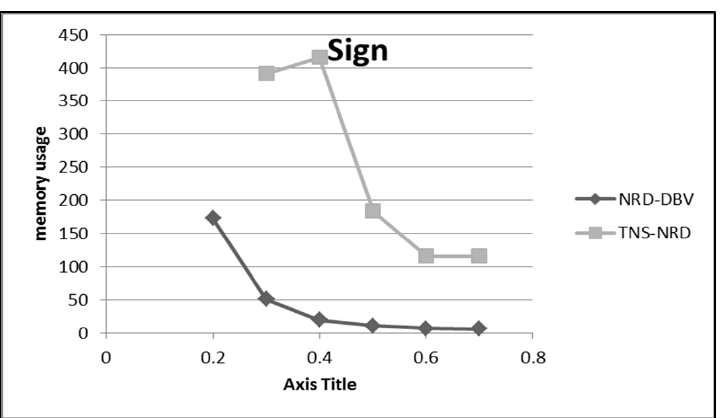
Figure 23. Comparison of memory usage for the TNS with the NRD-DBV algorithm for (Sign) dataset.